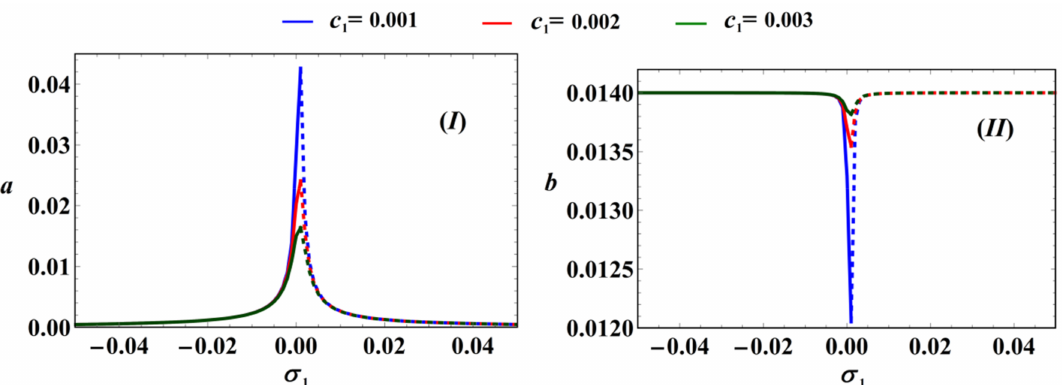
Figure 10. The frequency response at σ 2 = − 0.001, W = 0.448, and c 2 = 0.011 of: ( I ) a ( σ 1 ) and ( II ) b ( σ 1 )